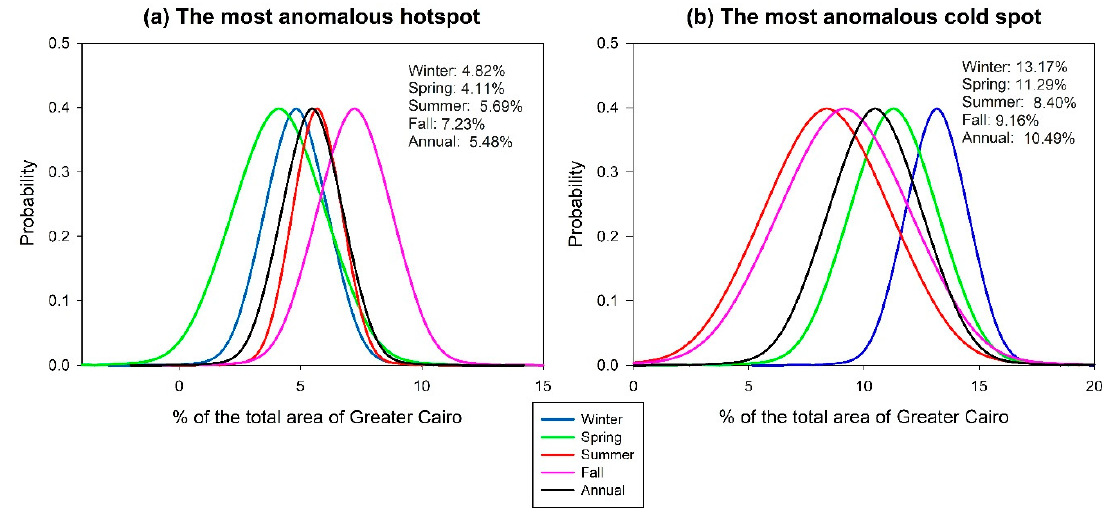
Figure 5. Probability distribution function (pdf) of the areas represented by the most anomalous hot (panel a ) and cold spots (panel b ), as compared to the total area of Greater Cairo. Results are presented on a seasonal basis for the period between 2003 and 2019. The provided numbers indicate the mean for each season.